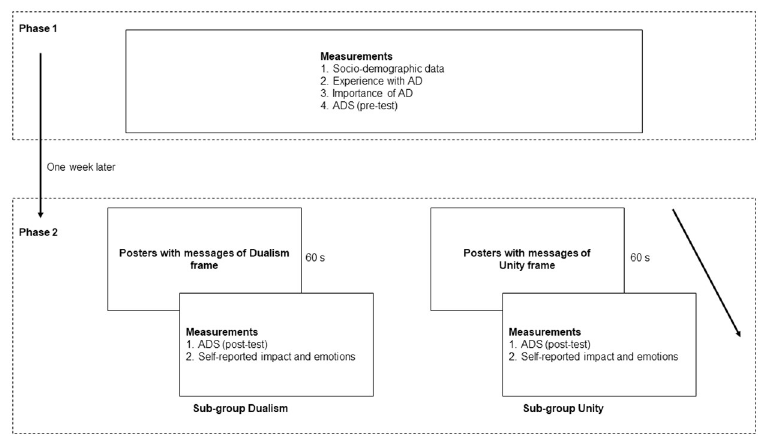
Fig 1. Study design and measurement